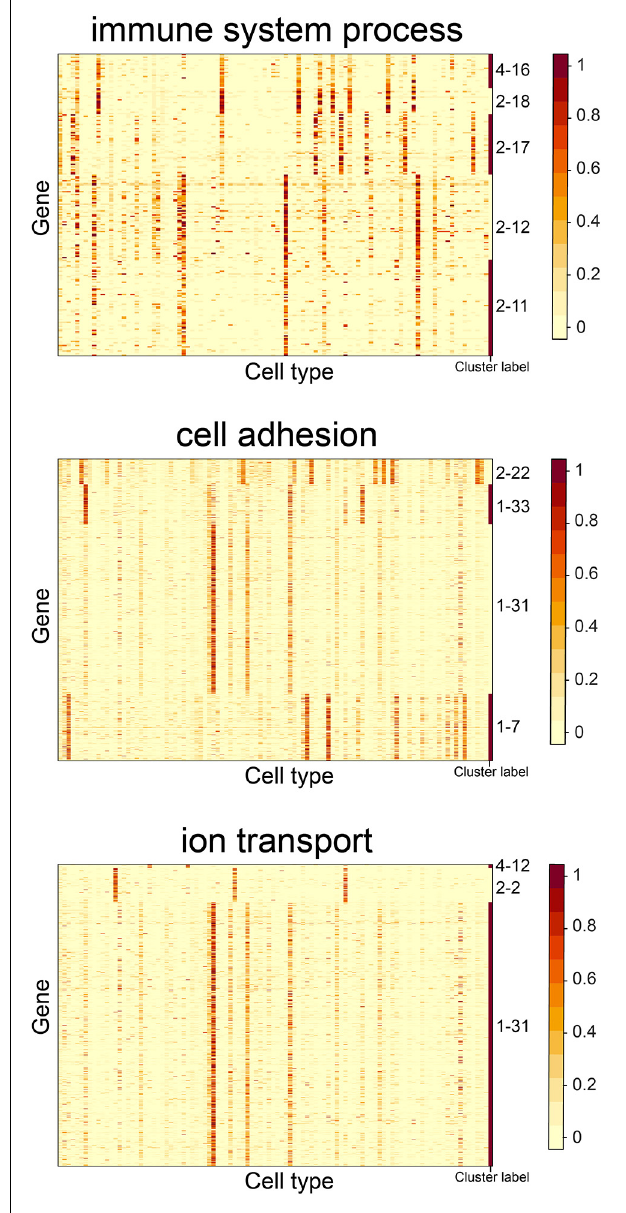
FIGURE 6 | Expression heatmap of the CTS gene clusters enriched in the GO terms “immune system process,” “cell adhesion,” and “ion transport.” Genes in the heatmap were sorted by the gene clusters, and the “cluster label” distinguished the genes from different gene clusters. The names of 101 cell types are listed in Supplementary Table 1 (“Smart_3m” column) in the same